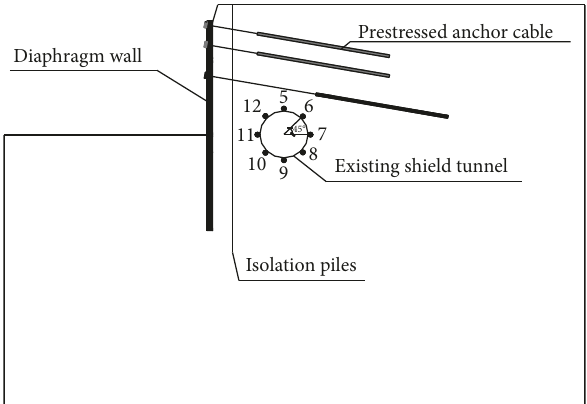
Figure 16: Layout of monitoring points for internal forces of the transverse tunnel structure.